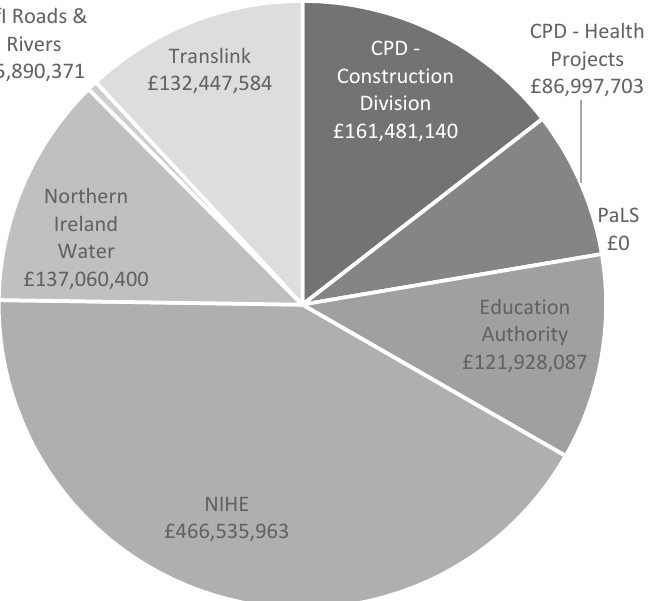
Figure 1. Value of works contracts procured 2021/22 (Department of Finance, 2022a).